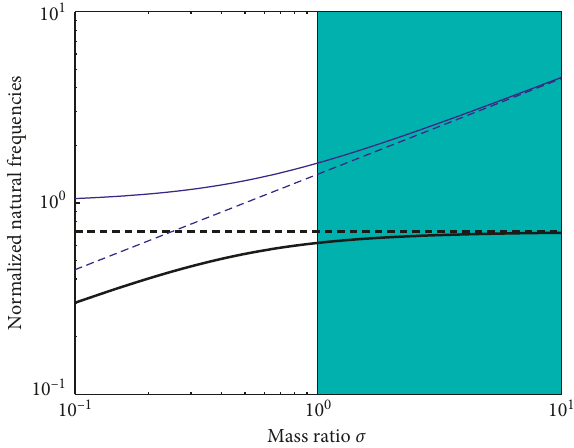
Figure 4: Exact (solid lines) and approximate (dashed) natural frequencies of the first (thick lines) and the second (thin) modes normalized by ω a for the two-body LES with the fixed spring ratio of κ o 1. The region, where κ o σ , is (cid:31) <